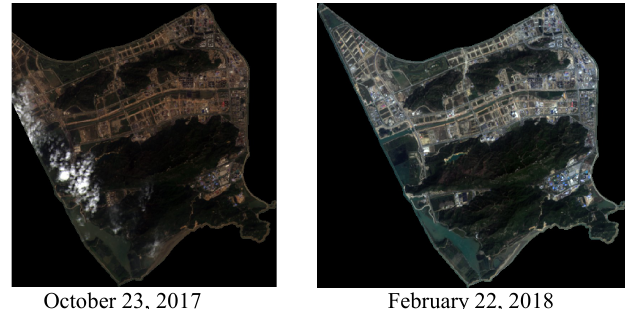
Fig 2. Landsat image of Hengqin new area from 2013 to 2018